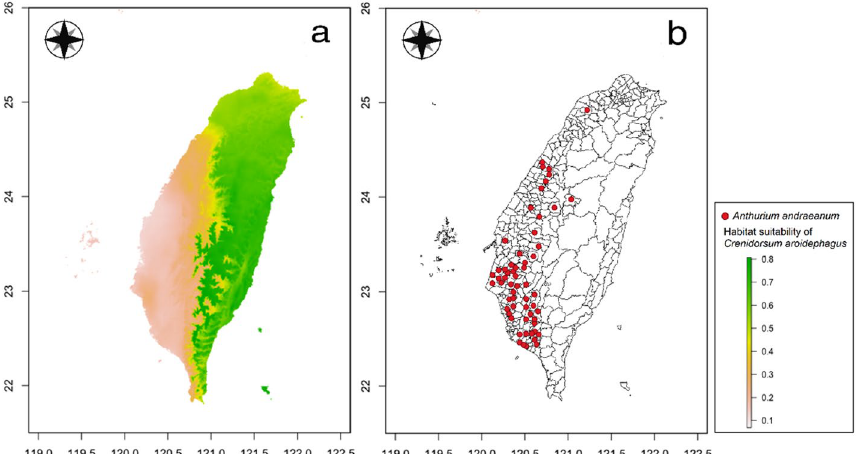
Figure 4. Comparison of potential distribution area of Crenidorsum aroidephagus and cultivation areas of Anthurium andraeanum in Taiwan: ( a ) potential distribution ( b ) cultivation areas. Maps were created using R version 4.04 (https:// www.r- proje ct. org/) and QGIS version 3.12.1 (www. qgis. org).